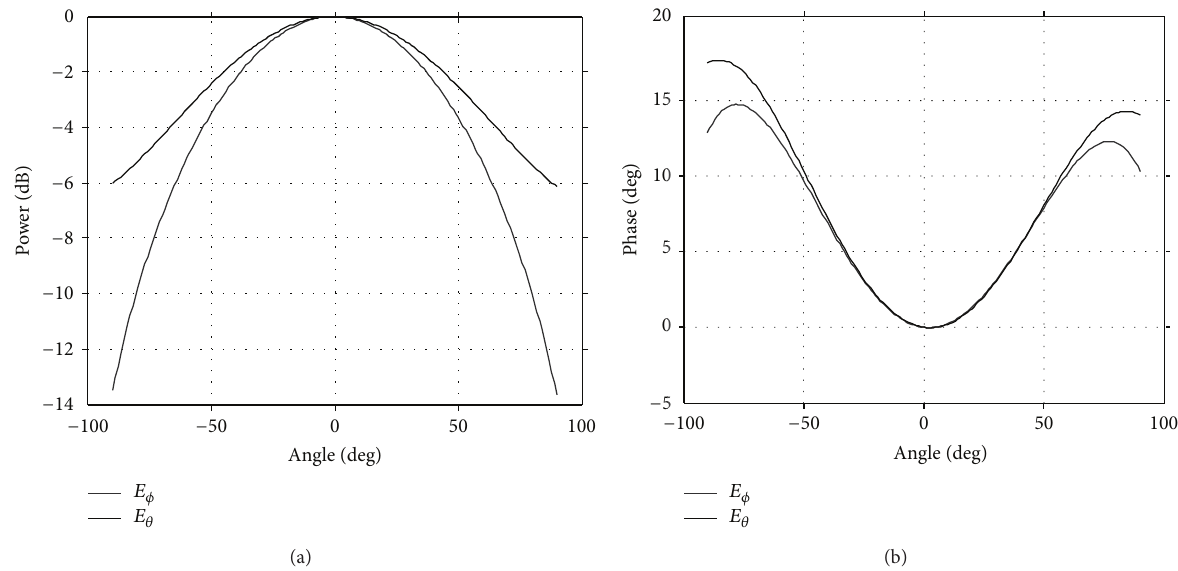
Figure 15: (a) Radiation pattern of circular waveguide at a distance 𝑟 = 0.75𝜆 . (b) Phase pattern of circular waveguide at a distance 𝑟 = 0.75𝜆 .